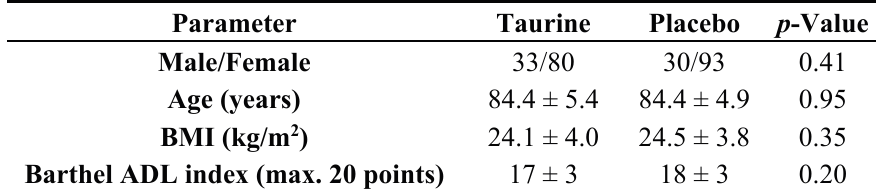
Figure 1. Flow Chart Inclusion. Kidney function is defined as creatinine clearance calculated with the Cockroft-Gault formula; miscellaneous patients: Three gastro-intestinal passage disorder, three language barrier, one hearing disability, thirteen secondary fractures, two had surgery in other hospital, eight cancer ± metastases, five primary total hip arthroplasty, six already participating in current study trial with contra lateral hip, three planned transfer to other hospital directly after surgery, one participating in other study trial. Table 1. Baseline